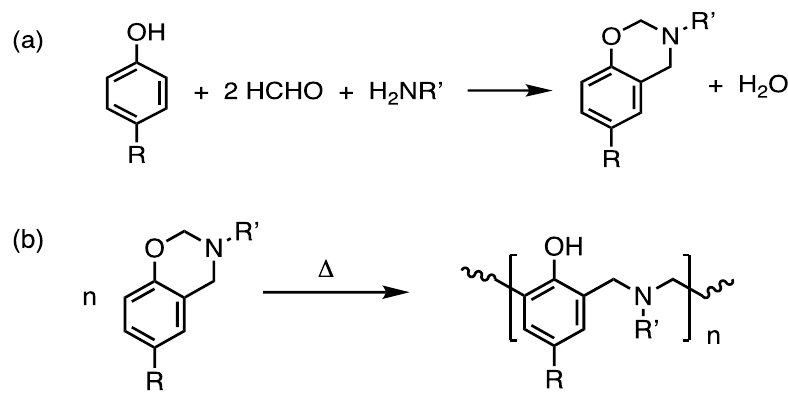
Figure 1. ( a ) Benzoxazine monomer synthesis from a phenolic derivative with the open o -positions, a primary amine, and formaldehyde. ( b ) Cationic ring opening polymerization of benzoxazine monomer showing no production of reaction side products.